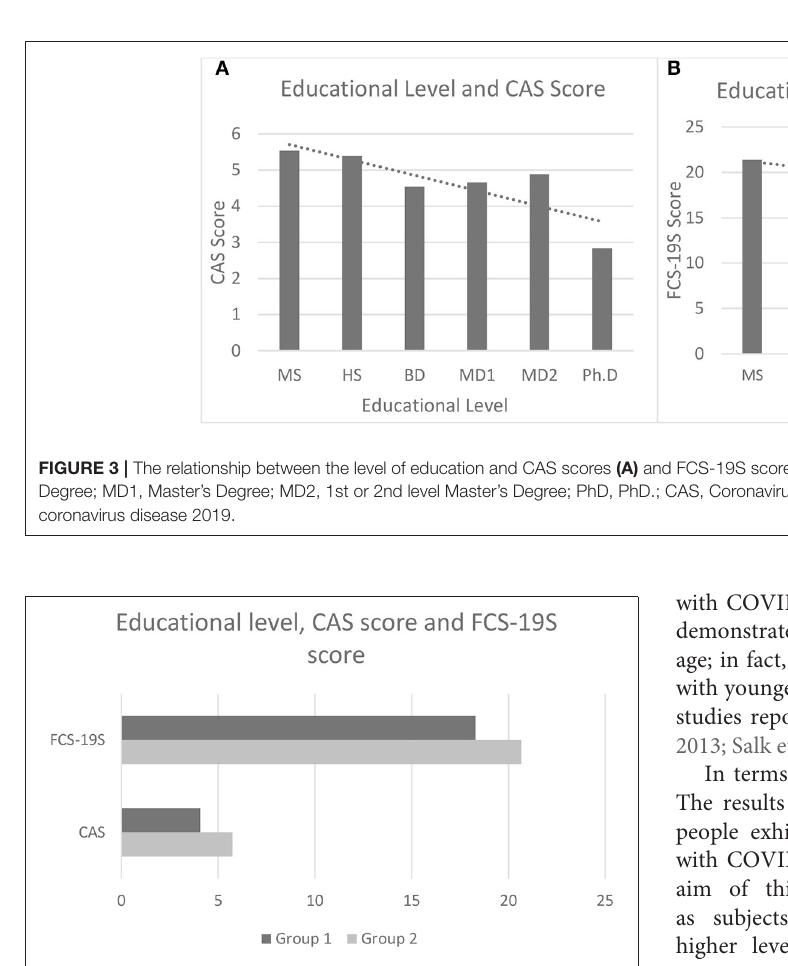
FIGURE 4 | The average CAS and FCS-19S scores in Group 1 vs. Group 2. CAS, Coronavirus Anxiety Scale; FCS-19S, Fear of COVID-19 Scale; COVID-19, coronavirus disease